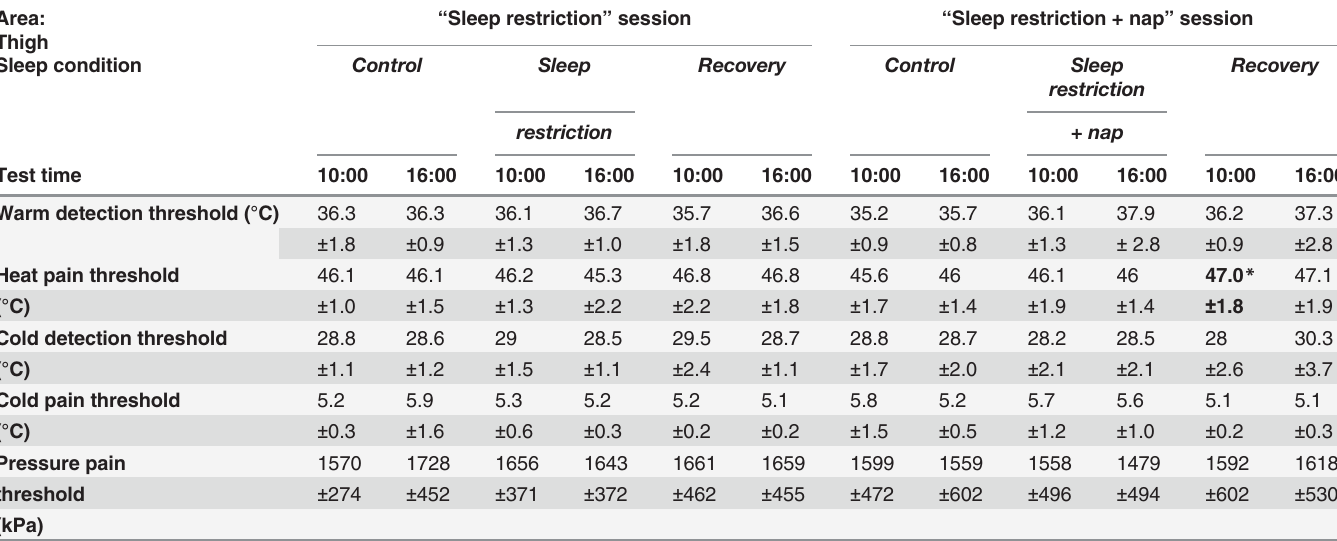
Quantitative sensory testing was performed twice daily, at 10:00 and 16:00, on the thigh area. Warmth and cold detection thresholds, and the thresholds for heat, cold and pressure pain were assessed in control, post-sleep restriction and recovery conditions, in the “ sleep restriction ” and “ sleep restriction + nap ” sessions, for each subject.